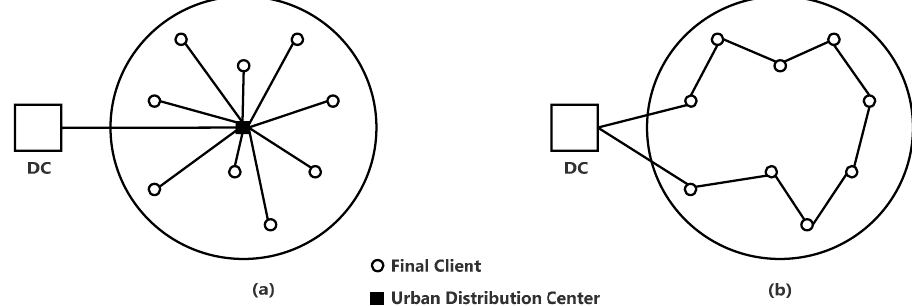
Figure 1. Schematic representation OF two-tier ( a ) and one-tier ( b ) distribution systems.